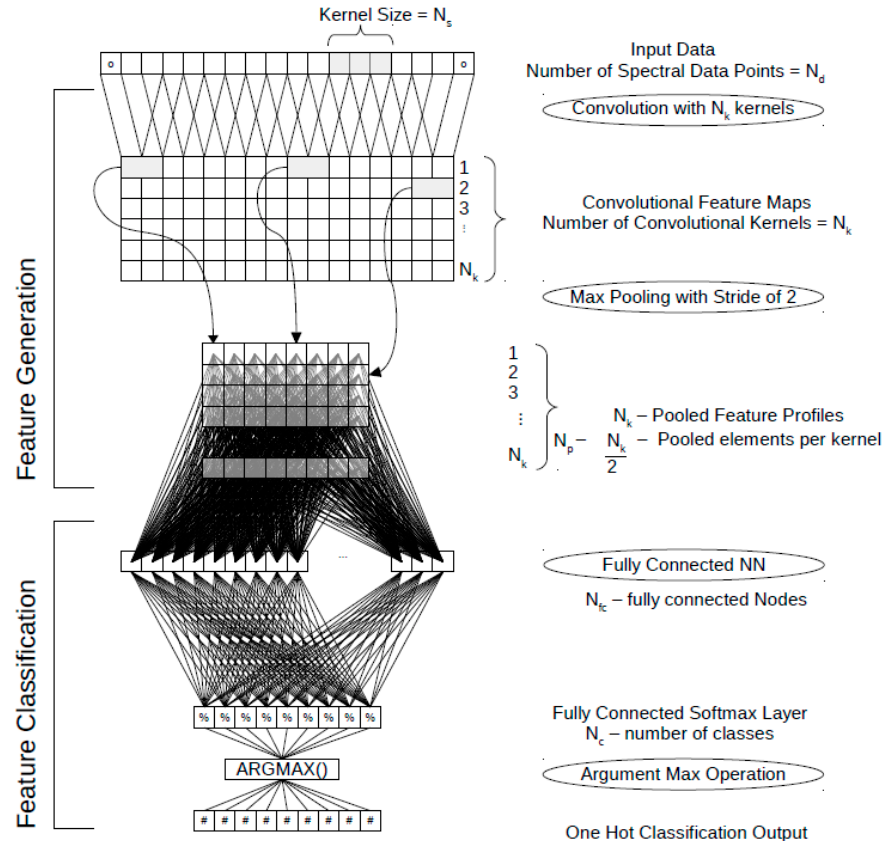
Figure 6. Detailed Convolutional Neural Network (CNN) architecture.